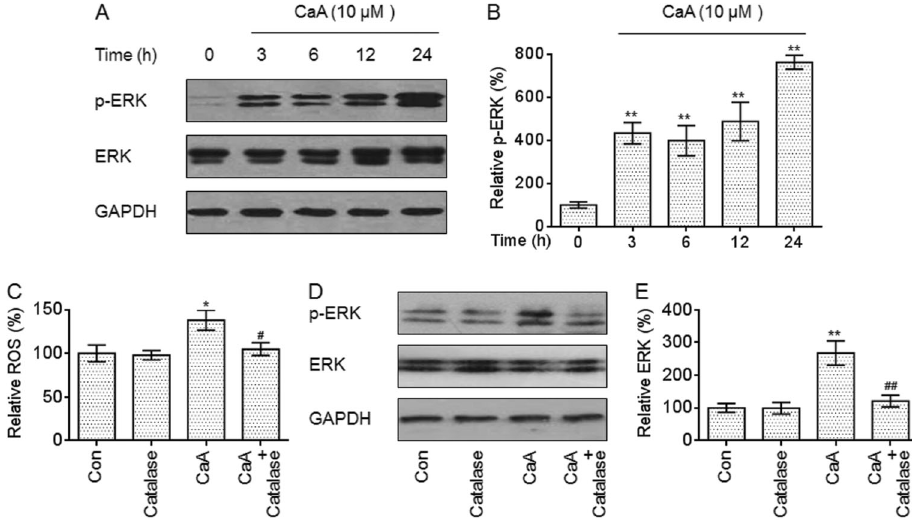
Figure 4. Caffeic acid (CaA) activated extracellular signal-regulated kinase (ERK) signaling by reactive oxygen species (ROS) in L-02 cells. A , B , L-02 cells were treated with 10 m M CaA for 0, 3, 6, 12, or 24 h. A , Western blots and ( B ) relative p-ERK protein levels. C - E , L-02 cells were pretreated with 10 nM catalase for 1 h and then exposed to 10 m M CaA for 24 h. C , ROS levels were measured with the DCF fluorescence method. The relative ROS ratios were determined by comparison with control cells. D , Western blots and E , relative p-ERK levels. *P , 0.05 and **P , 0.01 compared with controls; # P , 0.05 and ## P , 0.01 compared with cells treated with CaA alone (one-way ANOVA followed by Dunnett’s t